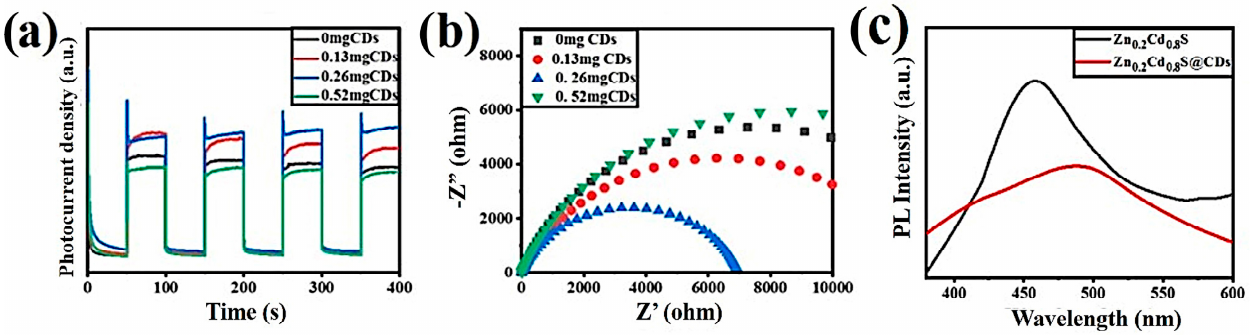
Figure 5. ( a ) Instantaneous photocurrent diagram of Zn0.2Cd0.8S@CDs with changes in the quantity of CDs quantity; ( b ) electrochemical impedance diagram of Zn0.2Cd0.8S@CDs with changes in the quantity of CDs; ( c ) steady-state fluorescence spectra of Zn0.2Cd0.8S and Zn0.2Cd0.8S@CDs.